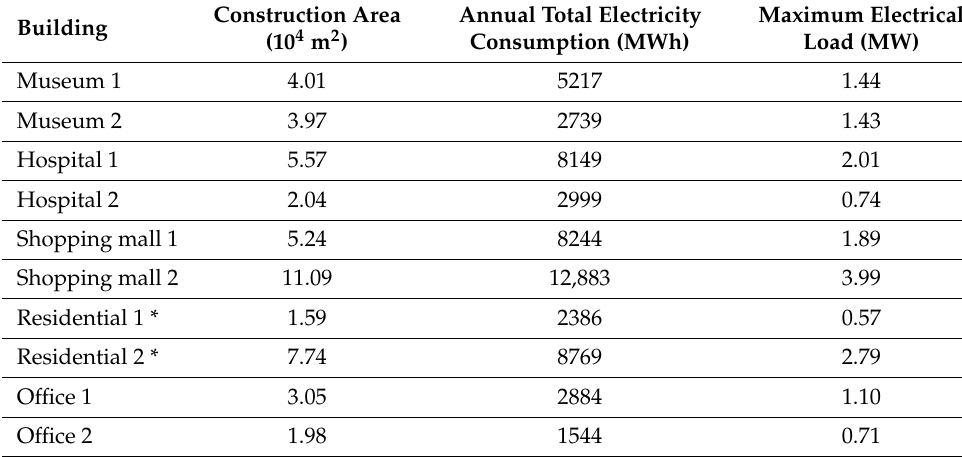
Figure 2. Description of the hydrogen supply route and research case in the Higashida area. Table 1. Basic information on the research target building.